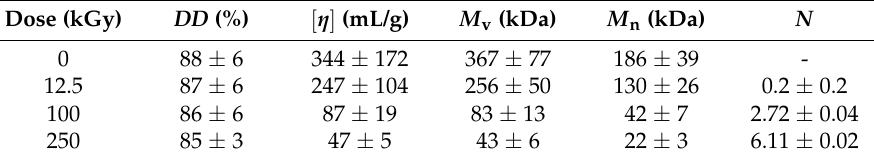
Table 1. Effect of electron beam irradiation on the degree of deacetylation, DD , intrinsic viscosity, [ η ] , viscosity average molecular weight, M v , number average molecular weight, M n , and average number of scissions, N